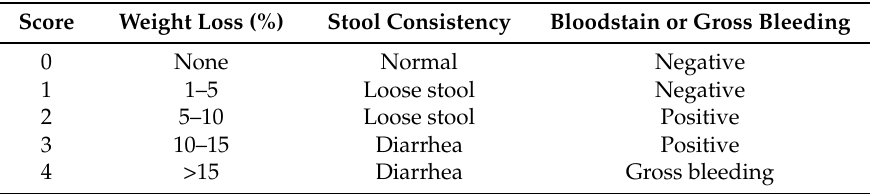
Table 1. Criteria for disease activity